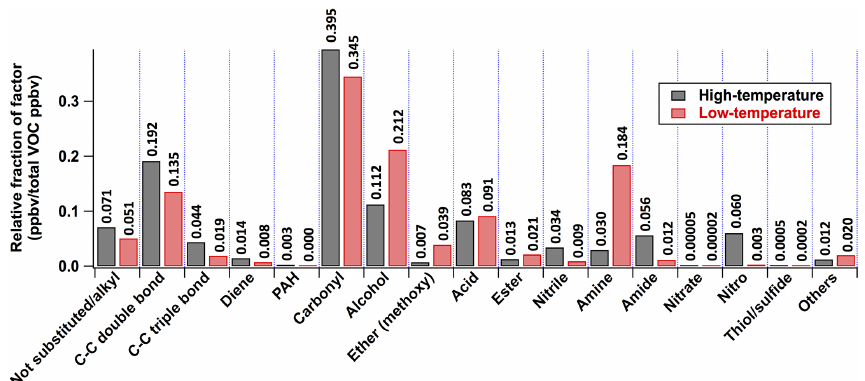
Figure 8. VOC composition in high- and low-temperature pyrolysis emission profiles (Fig. 3) sorted by 17 functional groups. Each group includes various structures and elemental composition. Some VOCs have multiple functional groups. These are counted once in each relevant category. For example, guaiacol is counted in the categories of “Alcohol” and “Ether (methoxy)”.